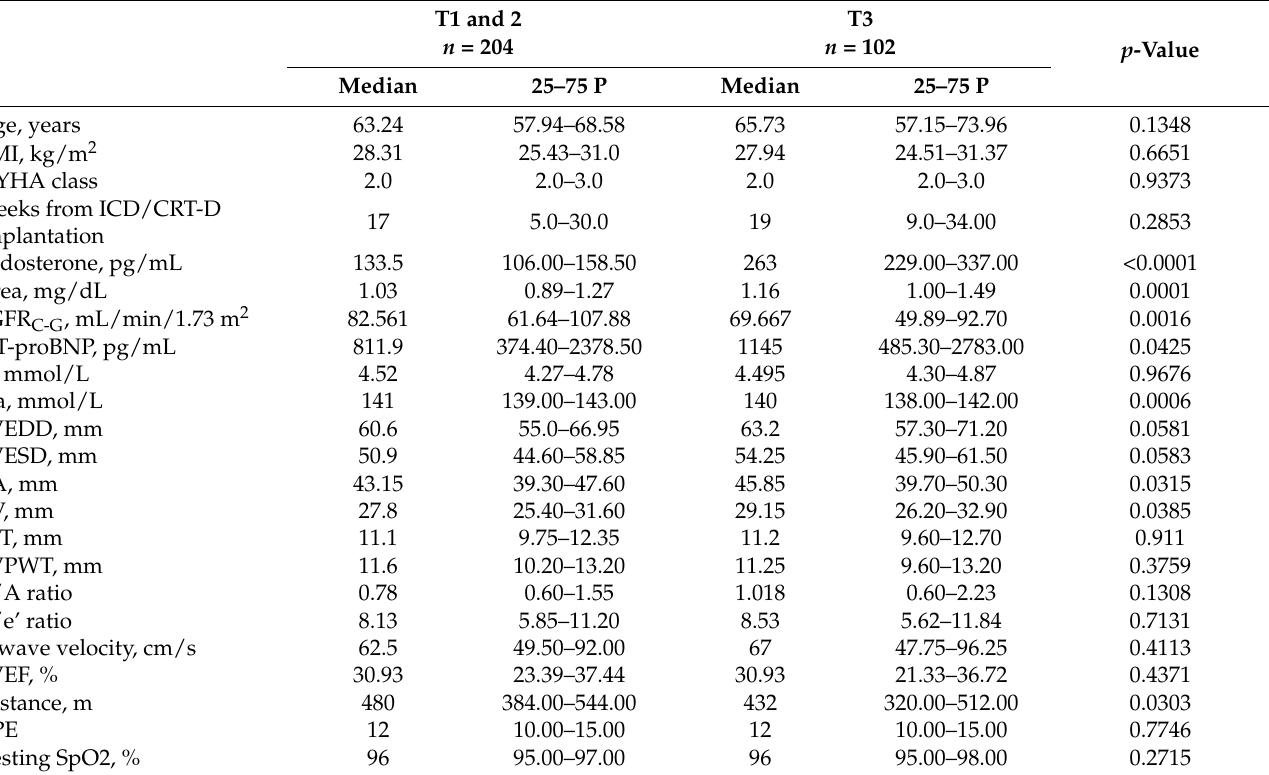
Table 1. Comparison of baseline clinical characteristics of patients with HF and LVEF <50% and implanted defibrillating device divided into subgroups of higher (T3) and lower (T1–T2) serum aldosterone concentration. Data are presented as median and (25–75P), and comparisons were made with the Mann–Whitney